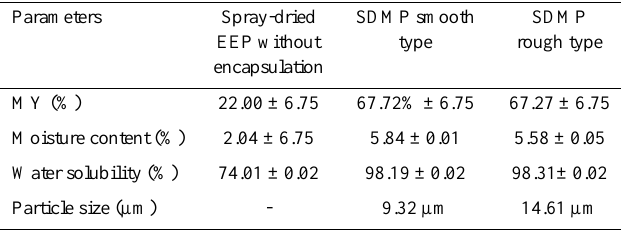
Table 1. The characterization of